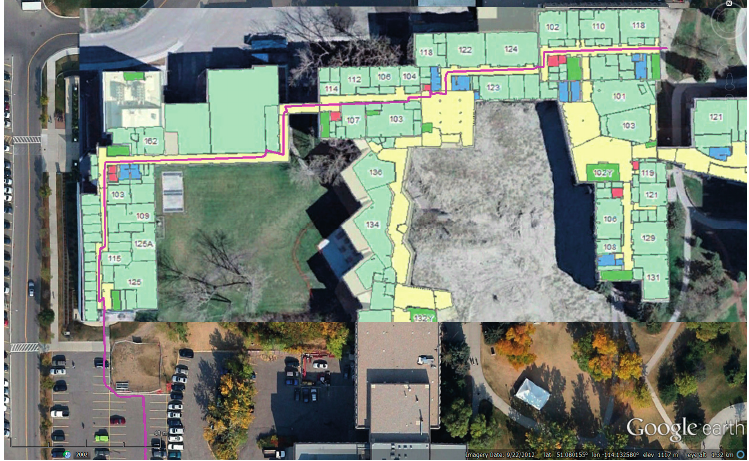
Figure 14. The trajectories used to generate WiFi DB in